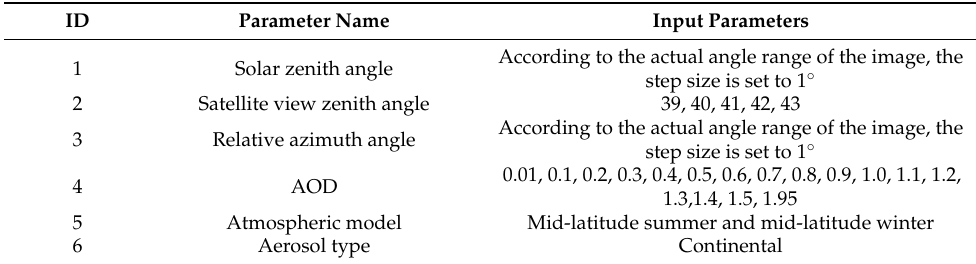
Table 3. Input parameters of 6S model.